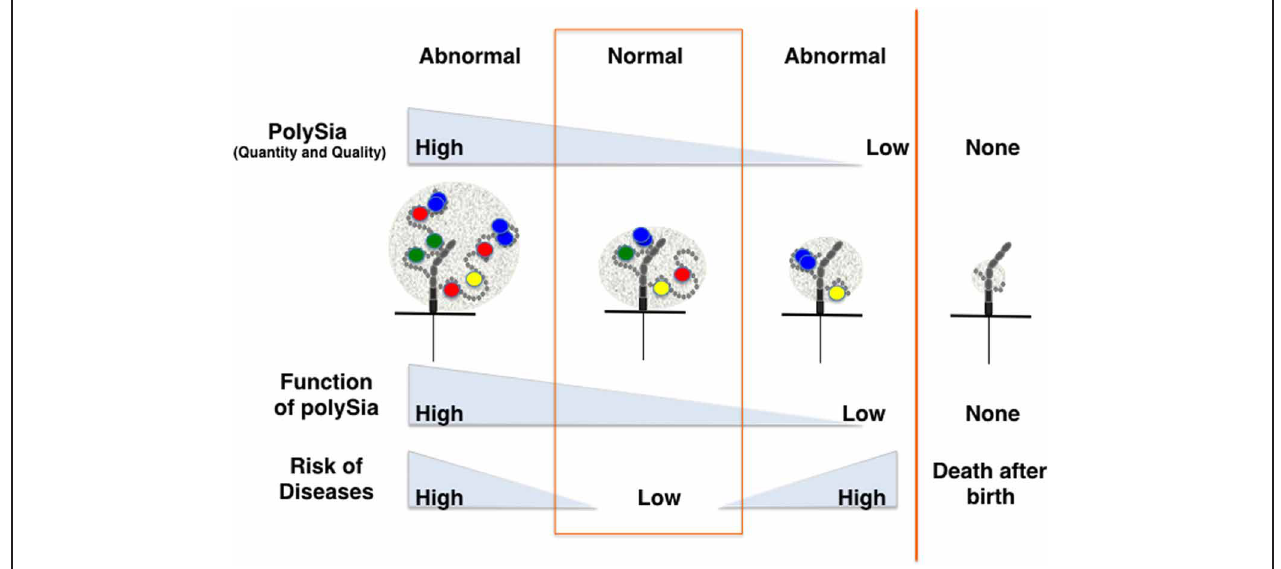
show that quantity and quality of polySia on NCAM are critically important for normal brain functions. Hyper- or hypo-polysialylation of NCAM might lead to the impairment of brain function through the stimulation or repression of dopamine-, BDNF- and FGF2-mediated